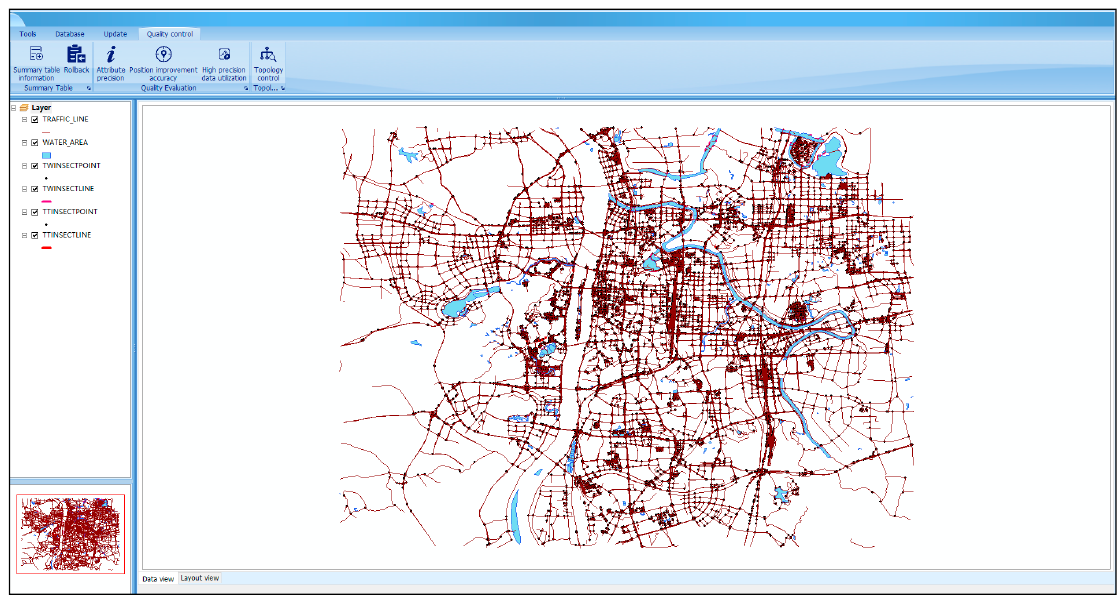
Figure 17. The user interface of the prototype system and experimental data.